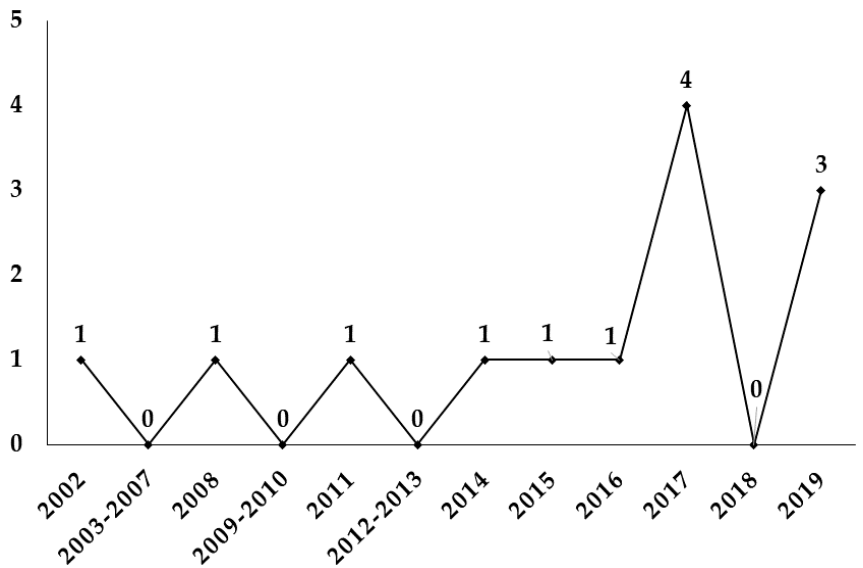
Figure 2. Number of articles per year.